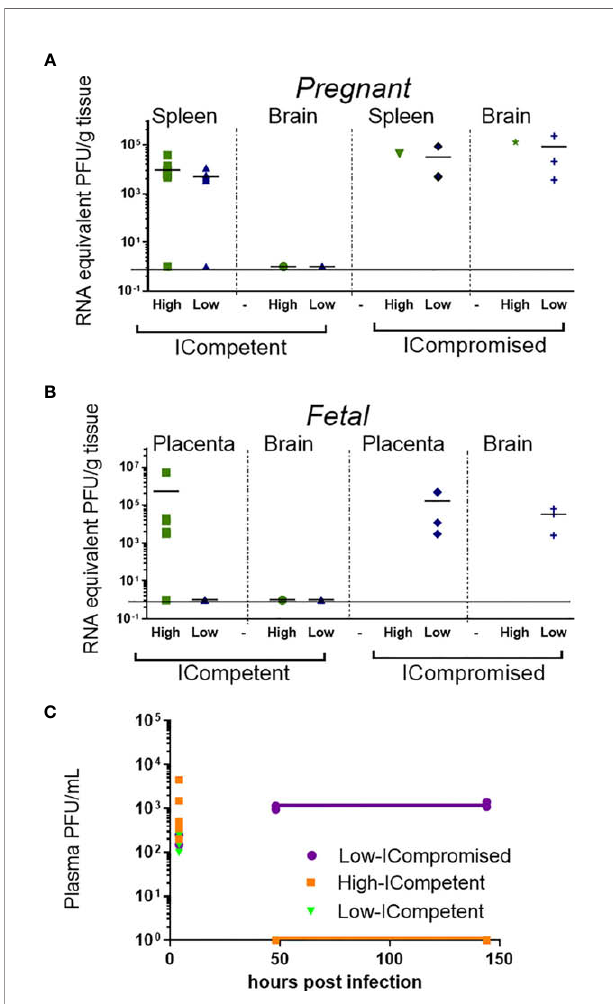
FIGURE 2 | Viral load detection in maternal and fetal tissues after ZIKV infection. Pregnant ICompetent and ICompromised mice were inoculated i.v. with low and high doses of ZIKV. (A, B) ZIKV RNA was measured via RT- qPCR in tissue samples obtained from maternal spleen and brain (A) and from placenta and fetal brain (B) . (C) The presence of ZIKV infectious particles in the plasma of infected dams was evaluated with a plaque assay 4, 48, and 144 hours post infection in ICompetent (mock n=11 dams; high ZIKV n=15 dams; low ZIKV n=9 dams) and ICompromised (mock n=3 dams; high ZIKV n=3 dams; low ZIKV n=3 dams)